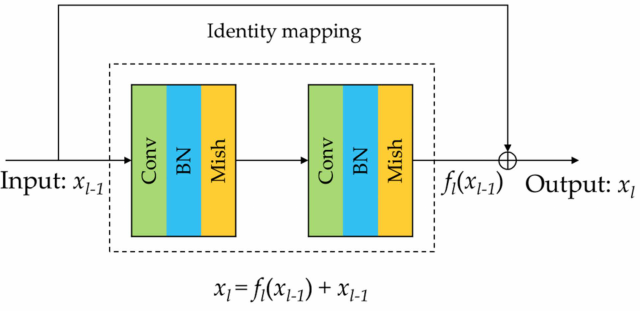
Figure 2. Illustration of the residual block in the